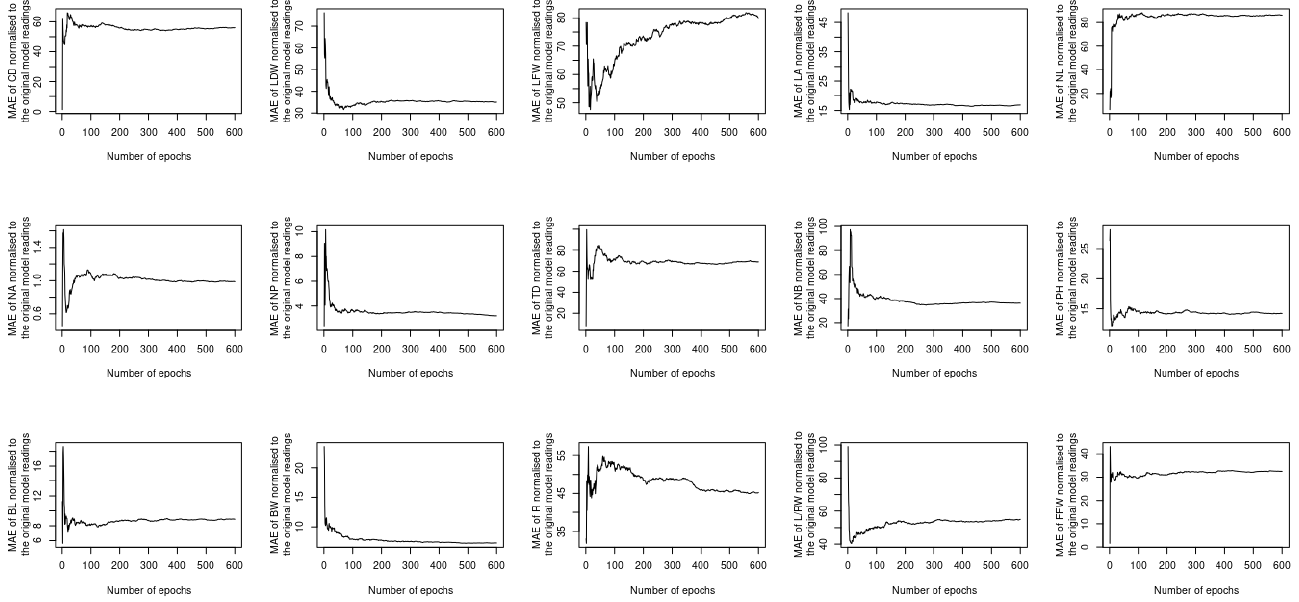
Figure 11. MAE of the newly constructed models normalized to the original model.